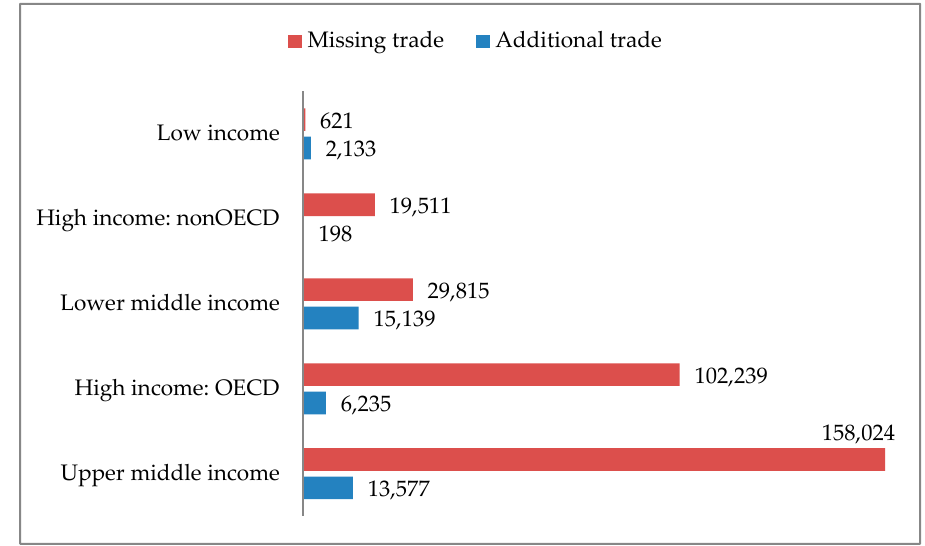
Figure 6. Trade e ff ect due to protection: Results for sectors with significant preference impacts (CES reference tari ff ). At world prices; millions of € . Source: Elaboration on data by COMEXT and TRAINS; 2017.